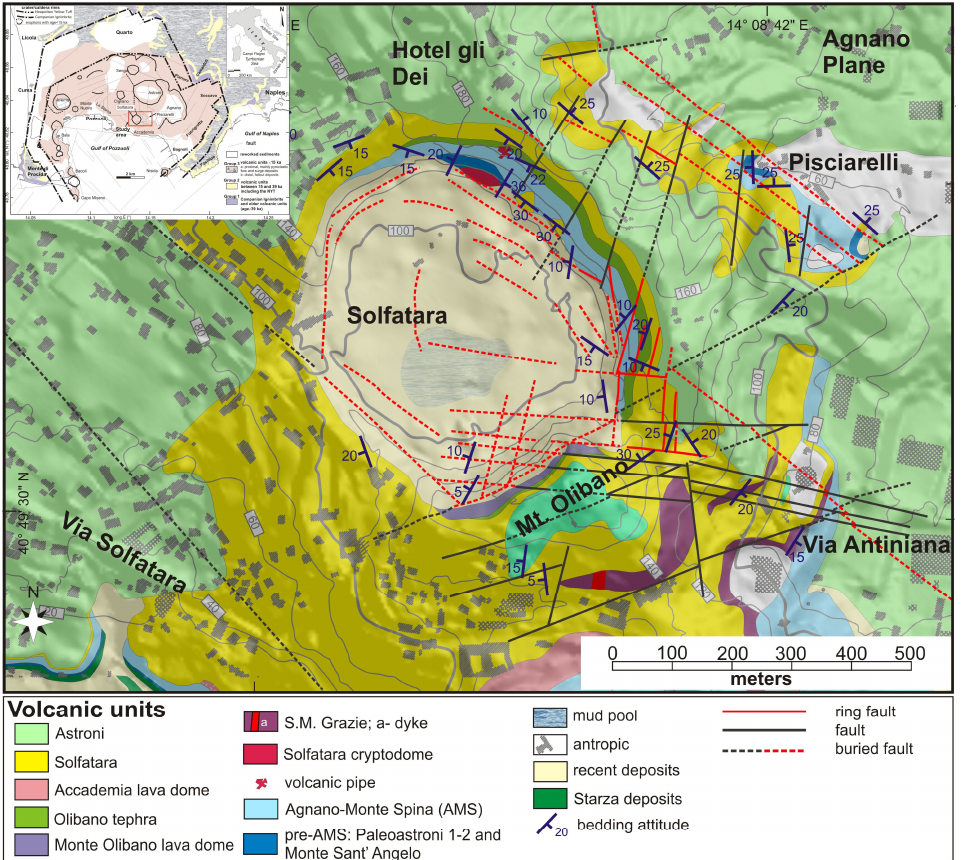
Figure 1. Structural/geological map of La Solfatara crater after Isaia et al.